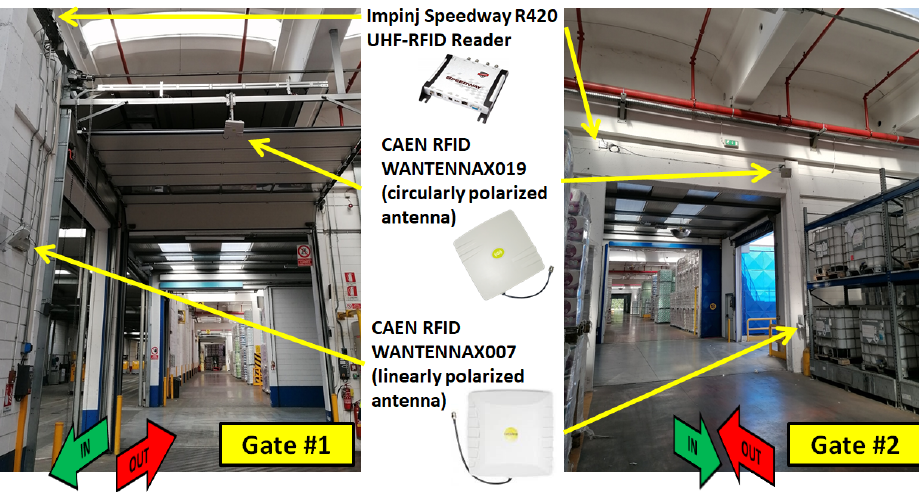
Figure 5. RFID Smart Gates installed at two entrances of the Tassignano warehouse. The forklifts are equipped with two OMNI-ID EXO 2000 on-metal RFID tags gate. One tag is placed on the forklift upright at a height of 2.6 m (Figure 6a), while the second tag is placed on the forklift roof at a height of 2.2 m (Figure 6b) for redundancy